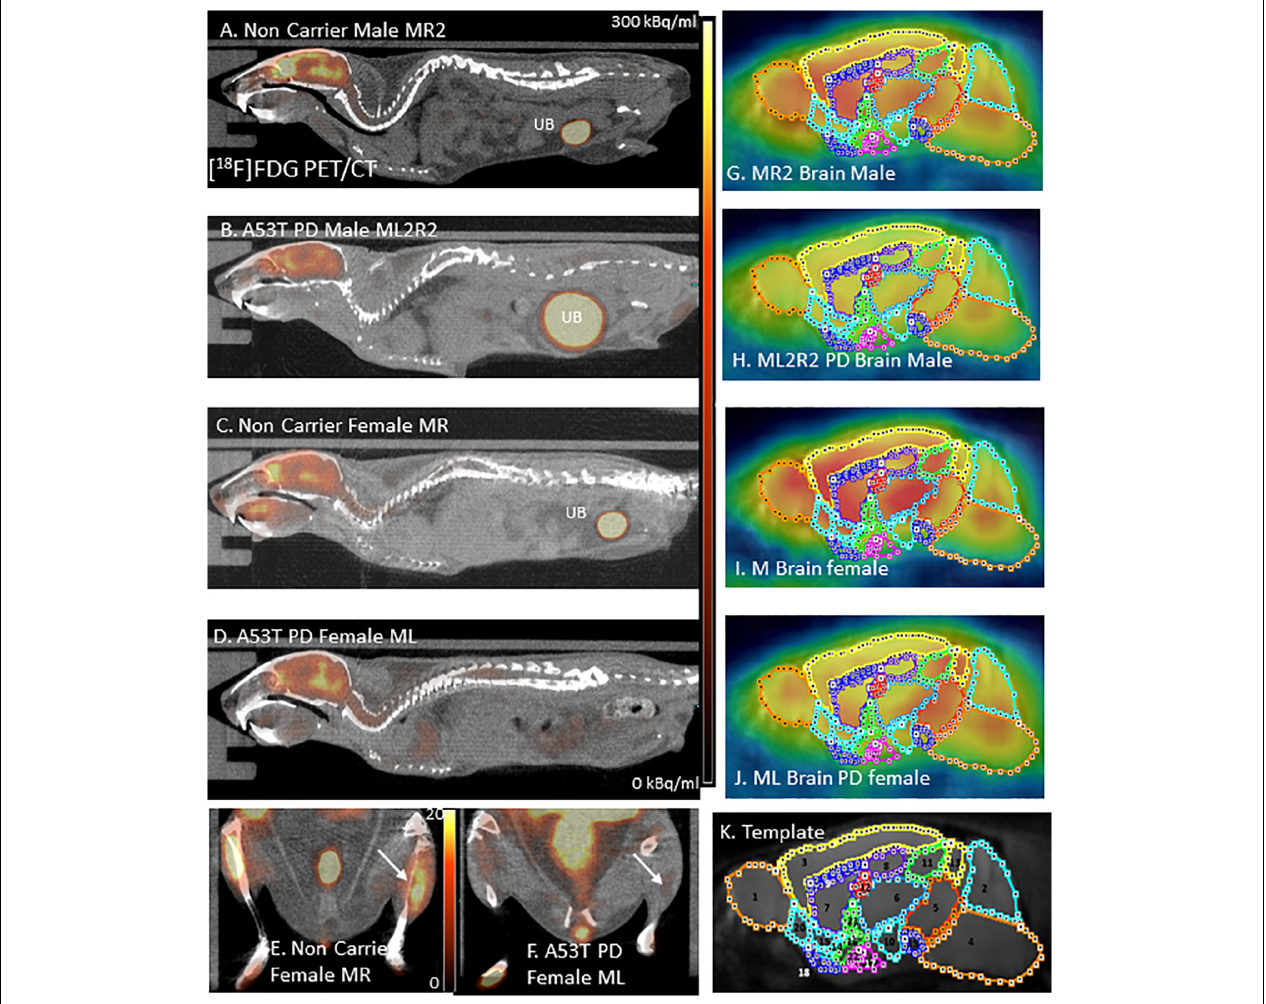
FIGURE 1 | (A) [ 18 F]FDG PET/CT full body mouse image of Control Male MR2; UB, Urinary bladder. (B) [ 18 F]FDG PET/CT full body mouse image of PD Male ML2R2; (C) [ 18 F]FDG PET/CT full body mouse image of Control Female MR; (D) [ 18 F]FDG PET/CT full body mouse image PD Female ML; (E) Hind limb [ 18 F]FDG PET/CT of non-carrier female MR mouse; (F) Hind limb [ 18 F]FDG PET/CT of PD female ML mouse; (G–J) [ 18 F]FDG images coregistered with MR template regions; and (K) Mouse MR template showing regions: 1. Olfactory bulb; 2. Cerebellum; 3. Neocortex; 4. Brainstem; 5. Midbrain; 6. Thalamus; 7. Caudate-Putamen; 8. Hippocampus; 9. Corpus Collusum; 10. Hypothalamus; 11. Superior colliculi; 12. Ventricles; 13. Inferior colliculi; 14. Ventral pallidum; 15. Nucleus accumbens; 16. Substantia innominate; 17. Amygdala; 18. Olfactory tubercle; 19. Substantia nigra; 20. Piriform area; 21. Globus pallidus; and 22. Magnocellular